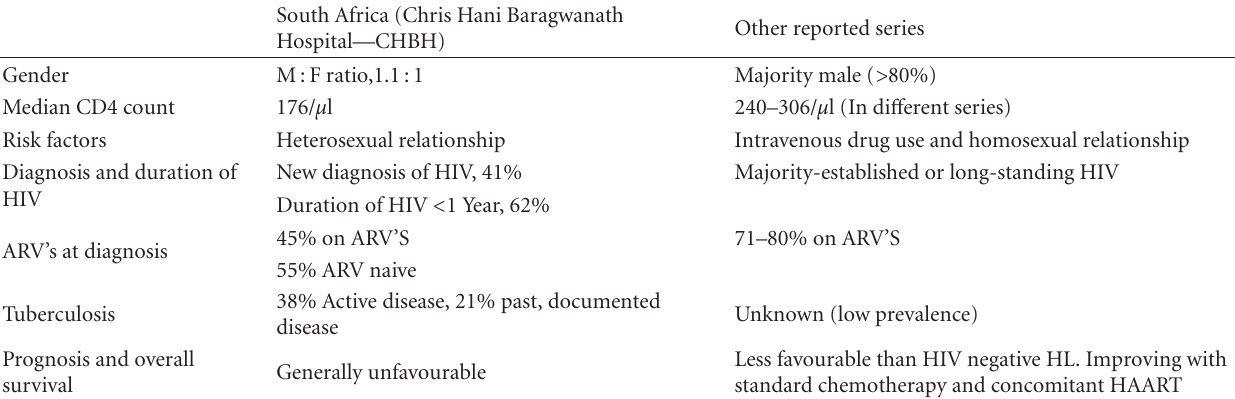
Table 2: Salient di ff erences between HIV-HL in South Africa and other reported